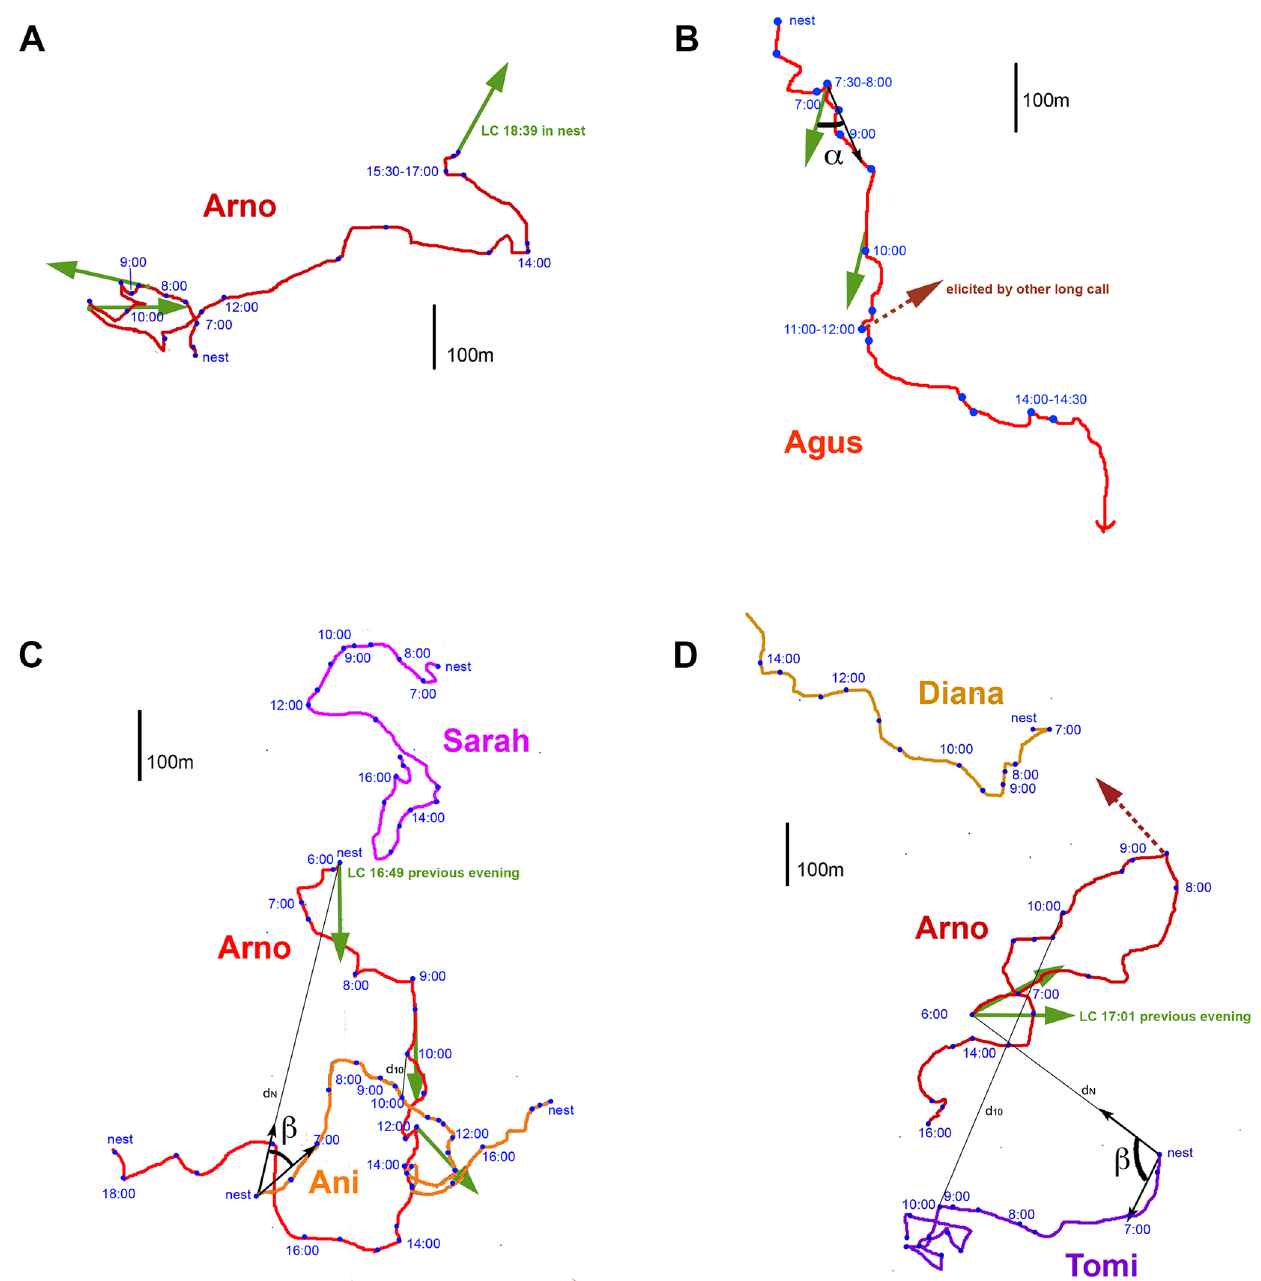
Figure 2. Travel maps showing travel routes and long calls of wild orangutans. Spontaneous long calls are indicated by green arrows, elicited long calls by red broken arrows. The deviation angle a between the long call direction and the travel direction was measured in 0.5-hour steps. Travel routes of flanged males: A) Arno (dominant male), 17 January, 1995; B) Agus, 8 April, 1995. Travel route of the focal animal and conspecifics the day after a long call was given shortly before nesting and from the nest area: C) Arno and the females Sarah and Ani, 8 August, 1994; D) Arno, the female Diana and the male Tomi, 15 April, 1996. For every individual, we measured the angle b between the direction in which the evening long call of the flanged male was heard, and the direction in which it took off from the nest the following morning. The distances between the two individuals were measured at the night nest and at 10 AM (d N , d 10 ). doi:10.1371/journal.pone.0074896.g002 spans after the first long call of the day, until nesting in the evening or until they disappeared from sight. Also, if the long call was given during rest, the first deviation angle could only be measured after the animal had changed its location. Therefore, the maximum sample size was usually obtained for the second hour after the long call was given (cf. Tables 1 and 2).